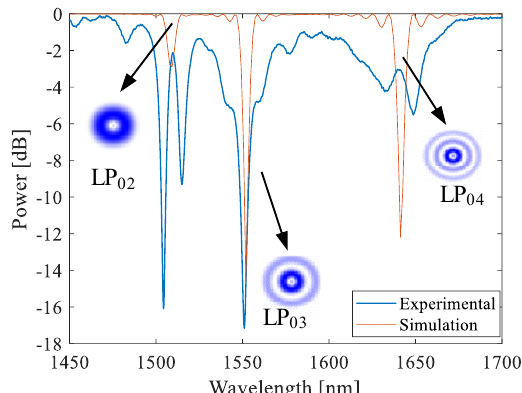
Fig. 4 . Experimental and theoretical spectrum results. The images indicate the corresponding modes for which the coupling has occured.